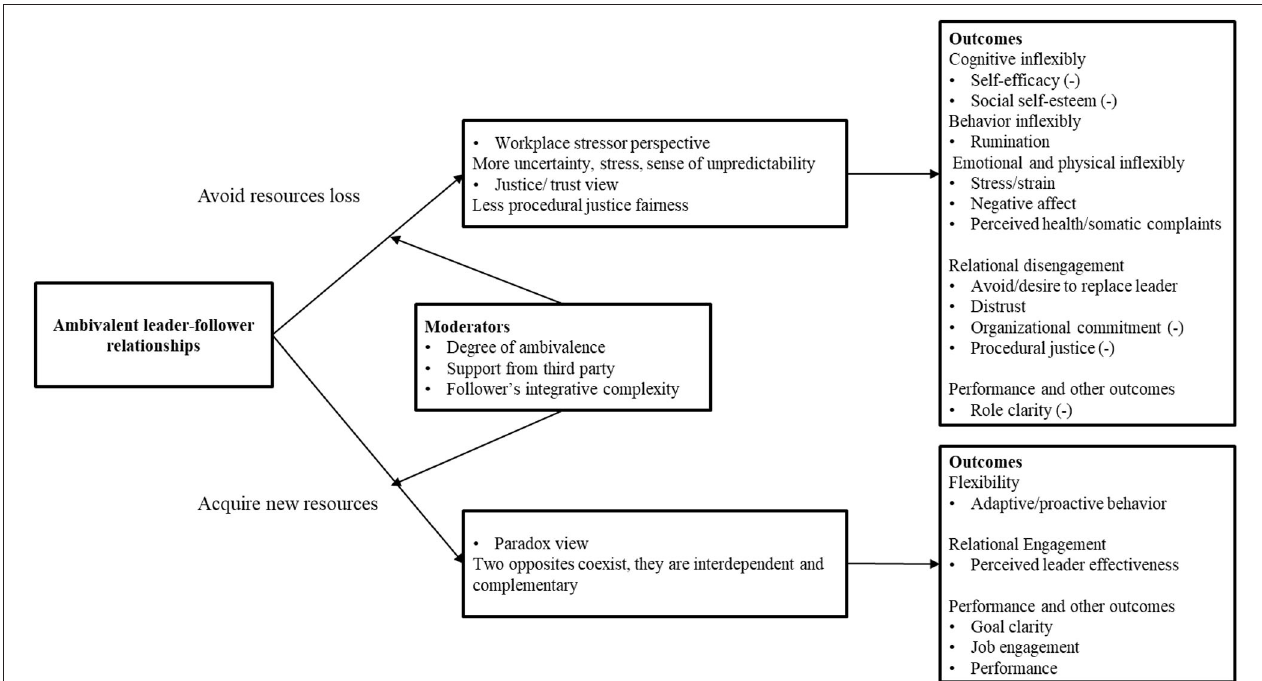
FIGURE 1 | Ambivalent leader–follower relationships at